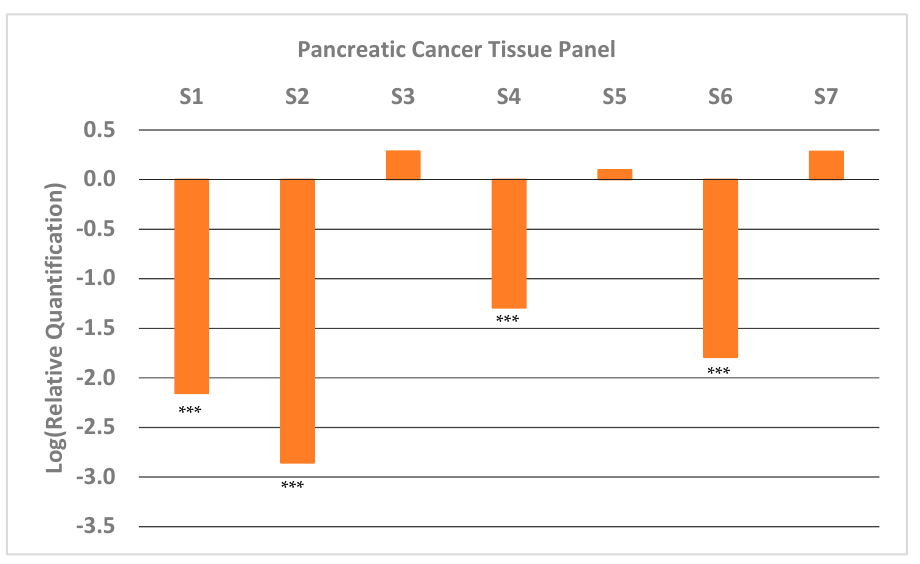
Figure 2. Relative Quantification (RQ) of the expression of GNMT in early-stage pancreatic cancer tumor samples from patients. Each sample was paired (PC and adjacent normal tissue) and expression of GNMT was determined and normalized to GAPDH. The expression in the normal tissue (Relative Quantification) was set to 1, and thus the Log (Relative Quantification) is 0. Significance from control, *** p < 0.001 (unpaired t-tests; n = 3) .